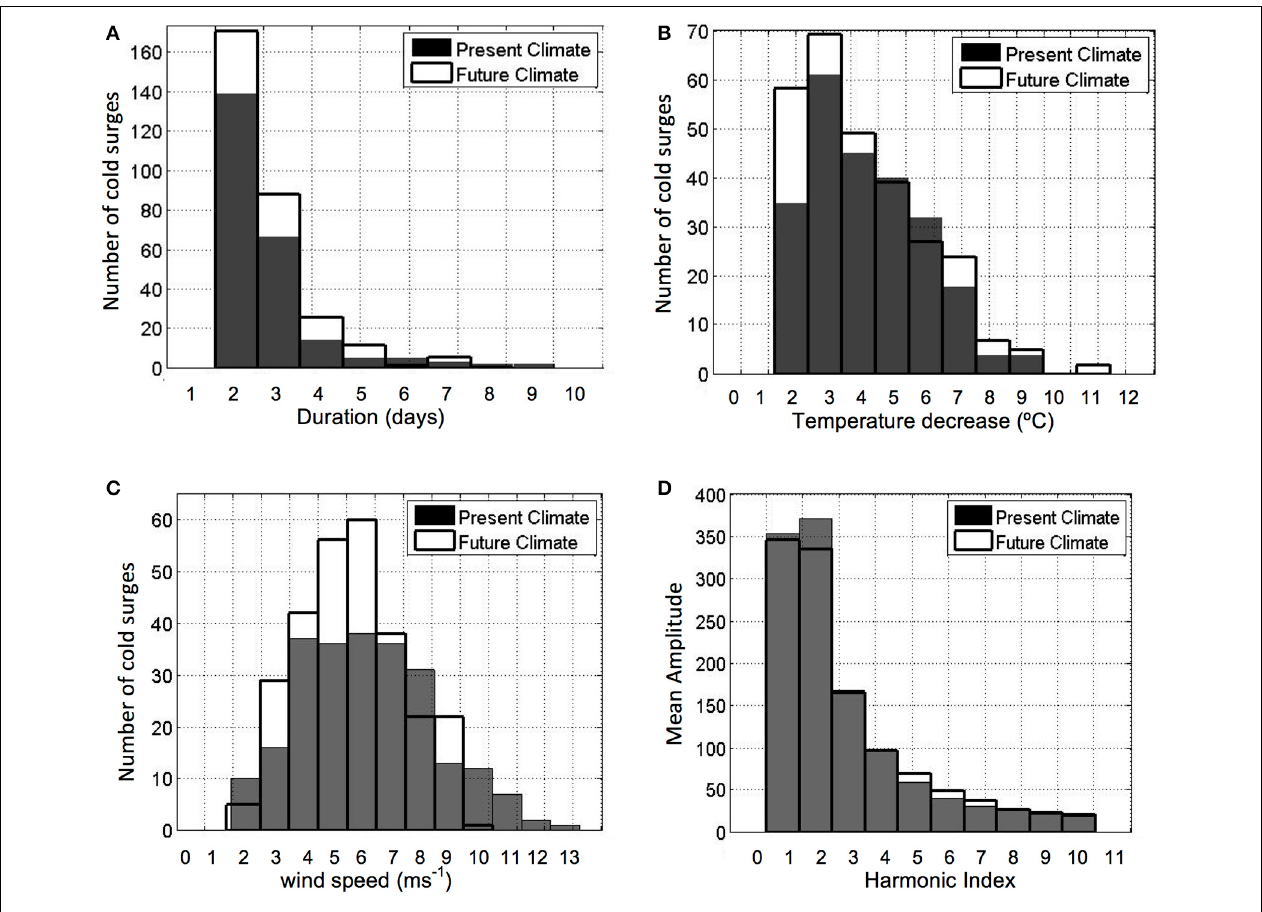
FIGURE 5 | Frequency of cold surges, computed from the TL959L60-AGCM for present and future (warmer) climate conditions, as a function of: (A) duration (days). (B) The associated temperature